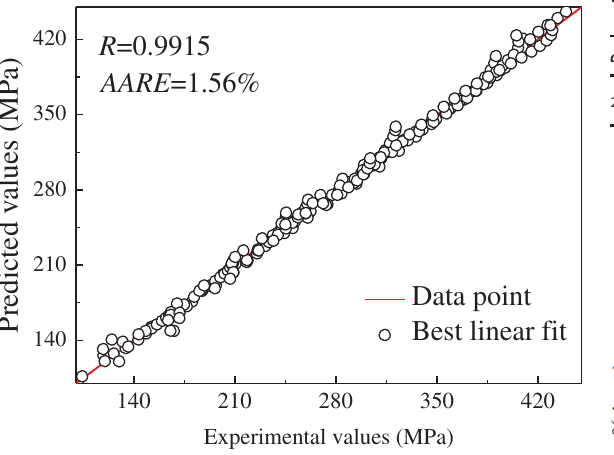
Table 10: Polynomial fit results of f 1 ð _ ε , T Þ of BR1500HS steel at low temperature with the strain of 0.002.